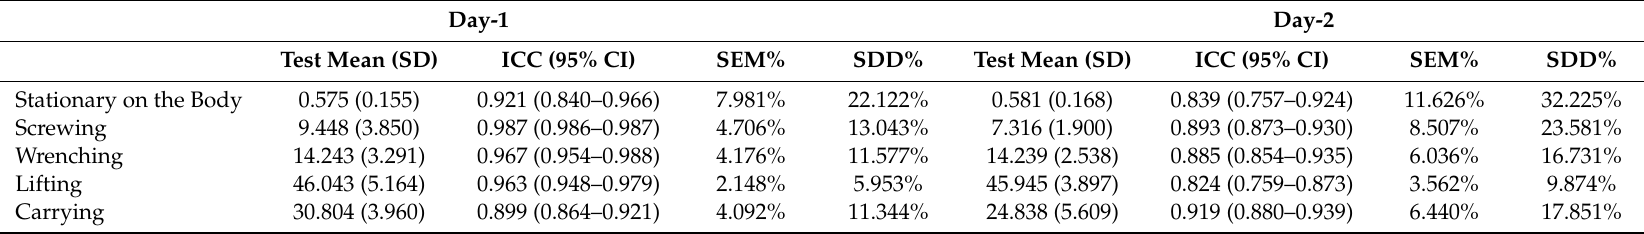
Table 6. Gyroscope trial-to-trial reliability assessment.